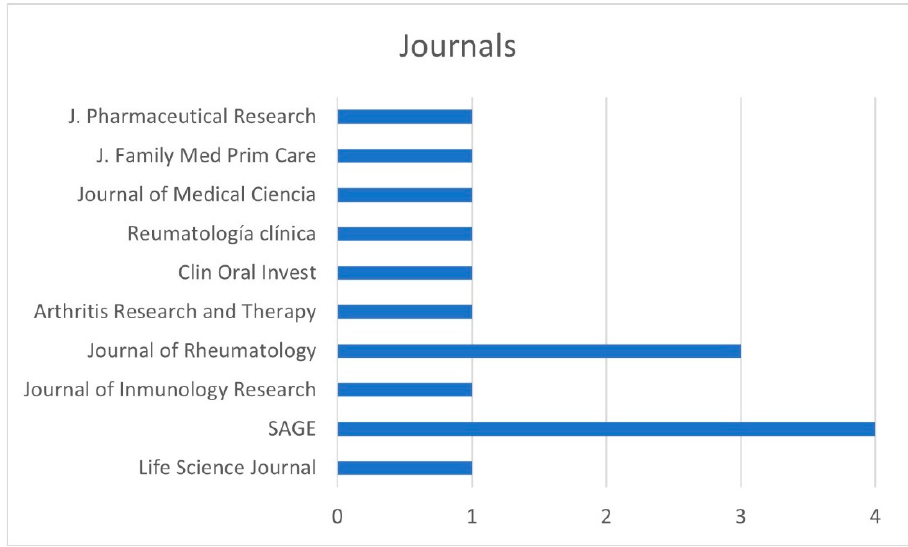
Figure 5. Distribution by journal of publication .